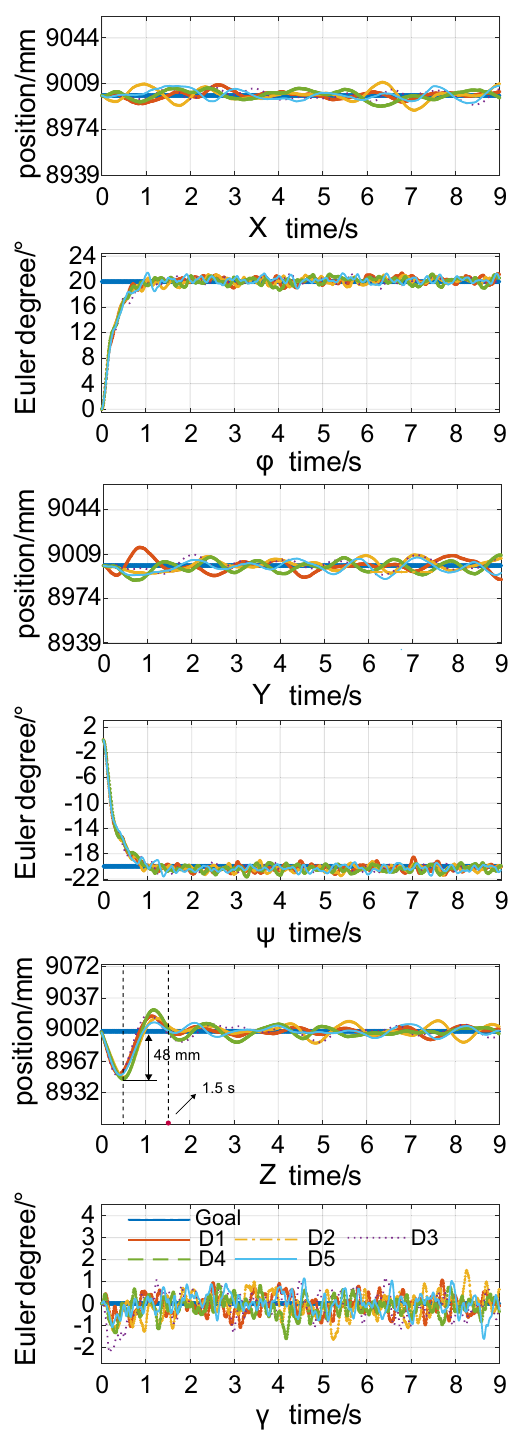
Figure 5. Response curves for tilt hovering control at different disturbance levels ( D 1 = D 0, D 2 = 2 D 0, D 3 = 3 D 0, D 4 = 4 D 0, D 5 = 5 D 0